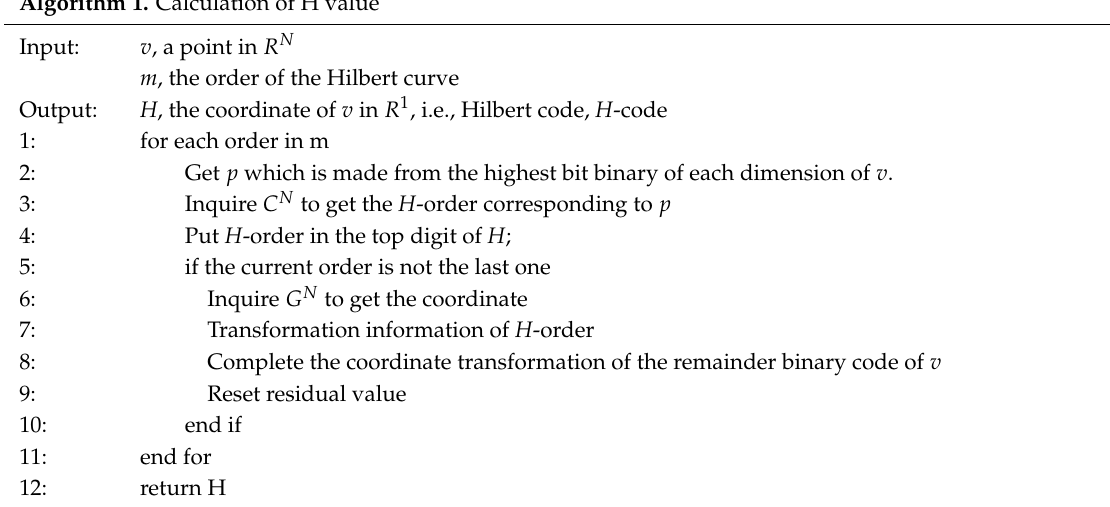
Algorithm 1. Calculation of H